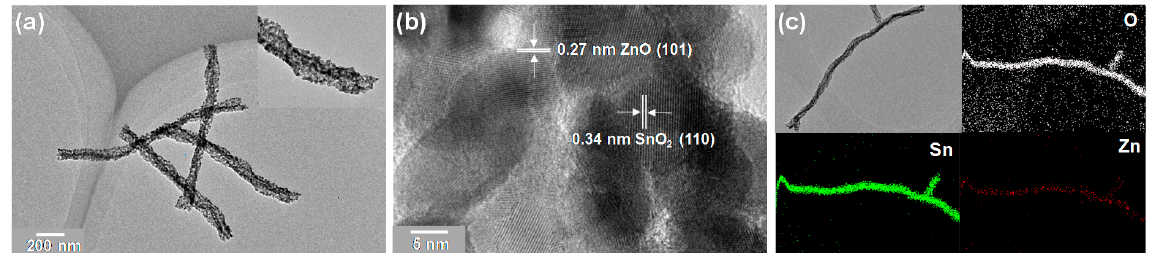
Figure 3. ( a , b ) TEM images of SnO 2 /ZnO-3 composite nanofibers. The inset of ( a ) is the enlargement. ( c ) Elemental mappings of SnO 2 /ZnO-3 composite nanofibers.